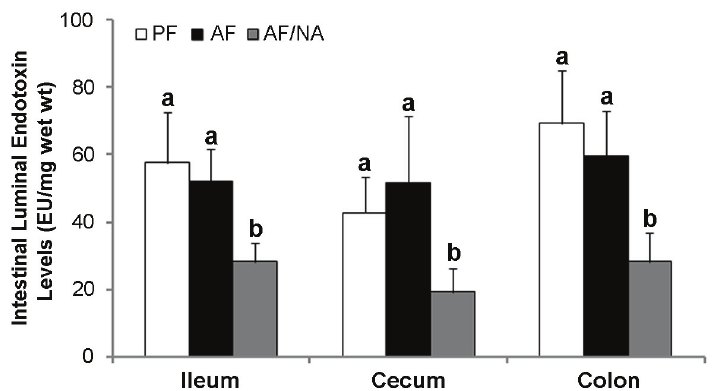
Figure 5. Intestinal luminal endotoxin levels in rats fed alcohol with or without nicotinic acid supplementation for 8 weeks. Endotoxin levels were measured by the limulus ameobocyte lysate method. Results are means ± SD ( n = 6–8). Significant differences ( p < 0.05, ANOVA) are identified by different letters. PF: pair-fed; AF: alcohol-fed; AF/NA: alcohol-fed with nicotinic acid supplementation.